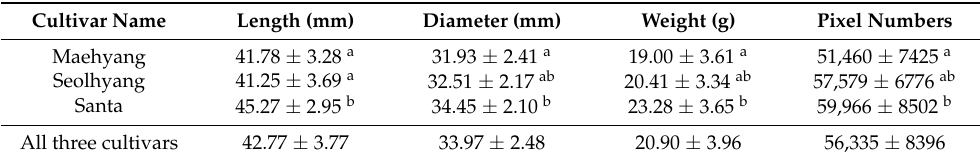
Table 2. Biometrical characteristics and pixel numbers of images in three strawberry cultivars at ripening stages.